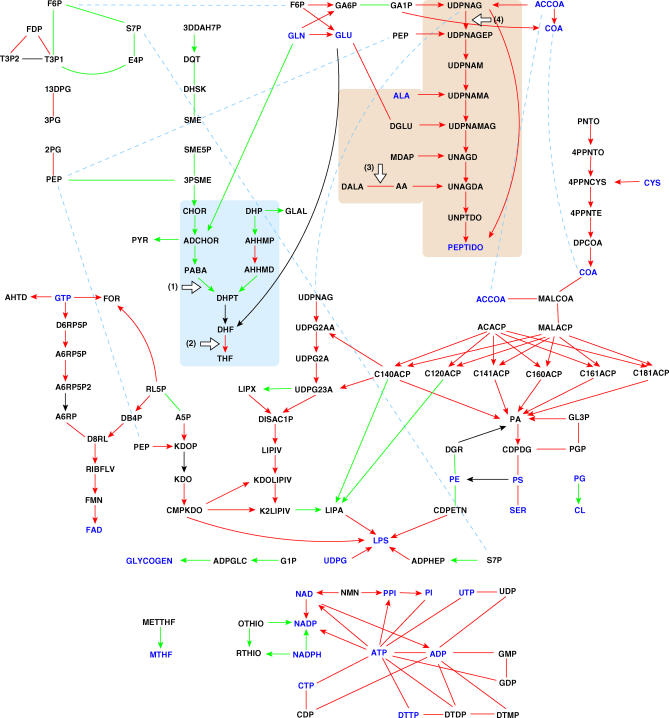
The Metabolic Core of E. coli
All reactions that are found to be active in each of the 30,000 investigated external conditions are shown. Metabolites that contribute directly to biomass formation [8] are colored blue, while core reactions (links) catalyzed by essential (or nonessential) enzymes [13] are colored red (or green). (Black-colored links denote enzymes with unknown deletion phenotype.) The blue dashed lines indicate multiple appearances of a metabolite, while links with arrows denote unidirectional reactions. Note that 20 out of the 51 metabolites necessary for biomass synthesis are not present in the core, indicating that they are produced (or consumed) in a growth-condition-specific manner. See Protocol S1 and Table S1 for the abbreviations of metabolites and a list of core reactions for E. coli, H. pylori, and S. cerevisiae. The folate and peptidoglycan biosynthesis pathways are indicated by blue and brown shading, respectively, and the white numbered arrows denote current antibiotic targets inhibited by: (1) sulfonamides, (2) trimethoprim, (3) cycloserine, and (4) fosfomycin. Note that a few reactions appear disconnected since we have omitted the drawing of cofactors.